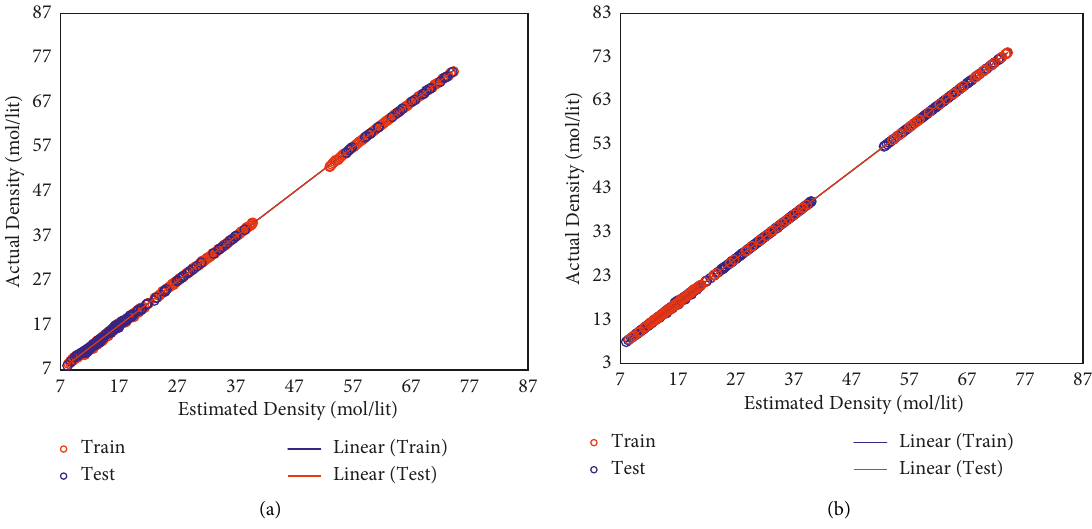
Figure 11: Cross plots of predicted and actual alkali metal densities for (a) ANFIS and (b)